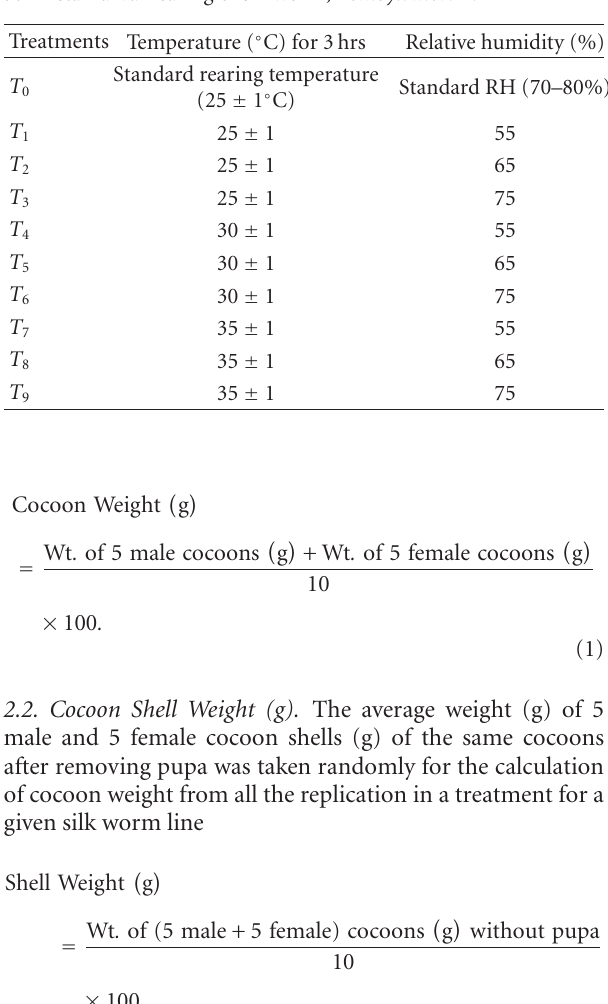
Table 1: Temperature and relative humidity regimes during 4th and 5th instar larval rearing of silkworm, Bombyx mori